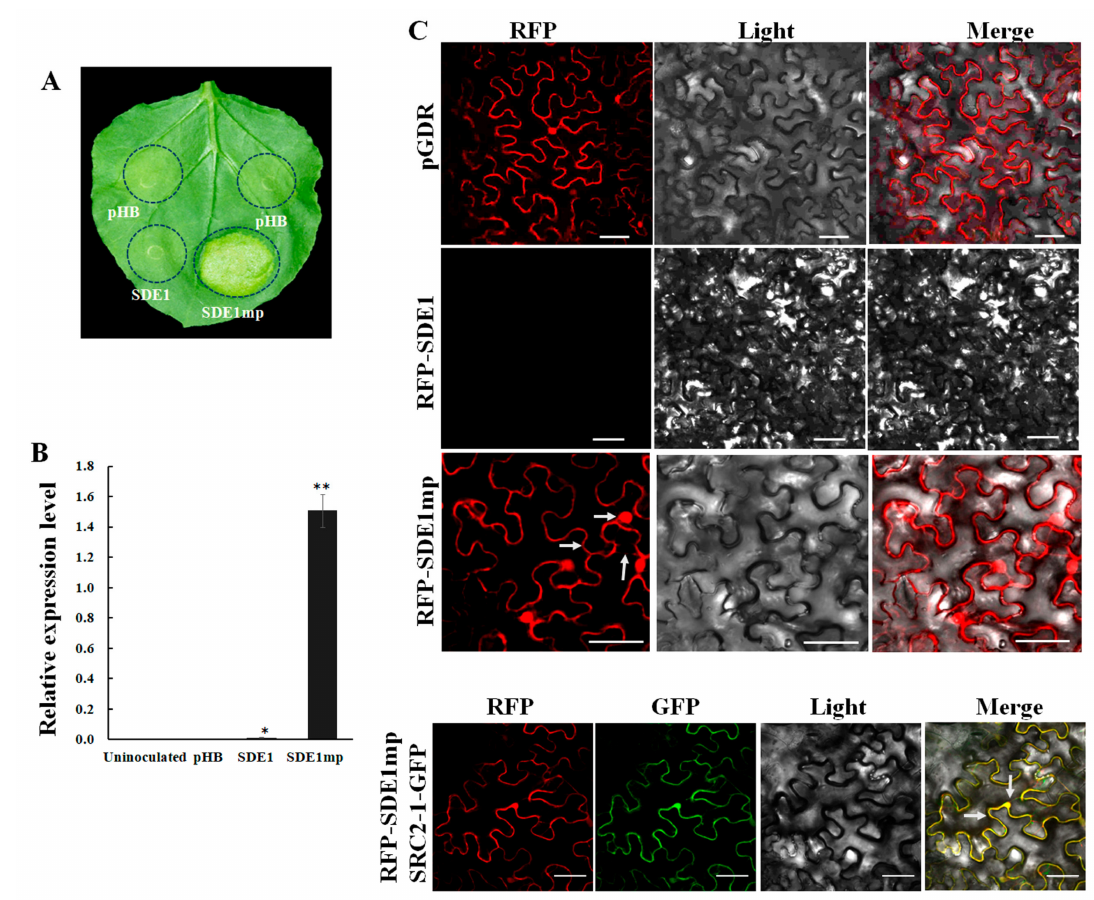
Figure 1. Expression of SDE1 in N. benthamiana by agroinfiltration. ( A ) Chlorosis induced by SDE1mp. The phenotype was observed at 3 dpi. ( B ) qRT-PCR assay of the transcript levels of SDE1 and SDE1mp at 3 dpi. The relative expression levels were normalized to internal control NbEF1a . Asterisks indicate significant di ff erences (* p < 0.05, ** p < 0.01, n = 3). ( C ) Visualization of RFP-SDE1 and RFP-SDE1mp fusion proteins in N. benthamiana cells. Arrows indicate the localization of RFP-SDE1mp in the cell membrane, cytoplasm, and nucleus. Samples were examined under the microscope at 2 dpi. Bar denotes 50 µ m. All experiments were repeated three